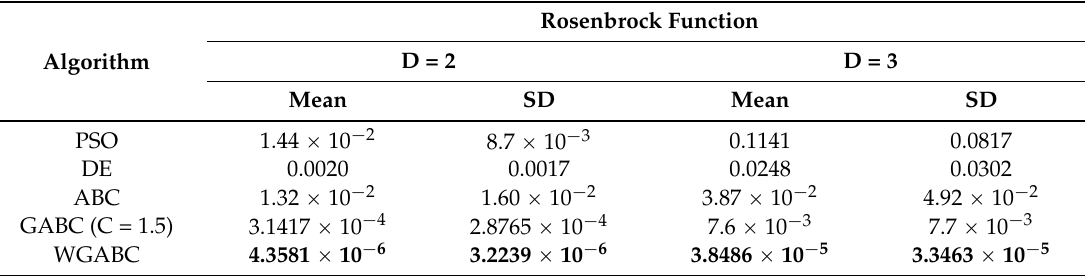
Table 4. The mean and standard deviation of the Rosenbrock function on the different algorithms.